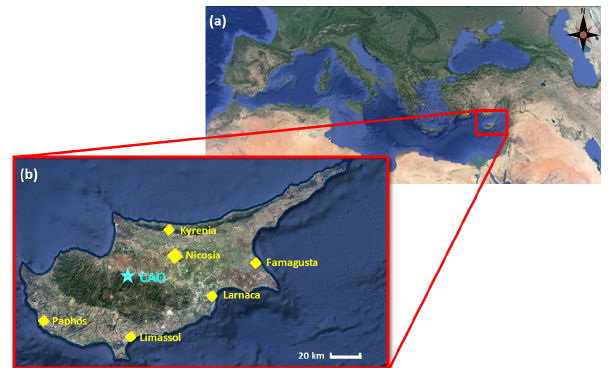
Figure 1. Maps of Cyprus and Mediterranean region. (a) Position of Cyprus in the Mediterranean region. (b) The sampling site and ma- jor Cypriot agglomerations are displayed as a blue star and yellow diamonds,